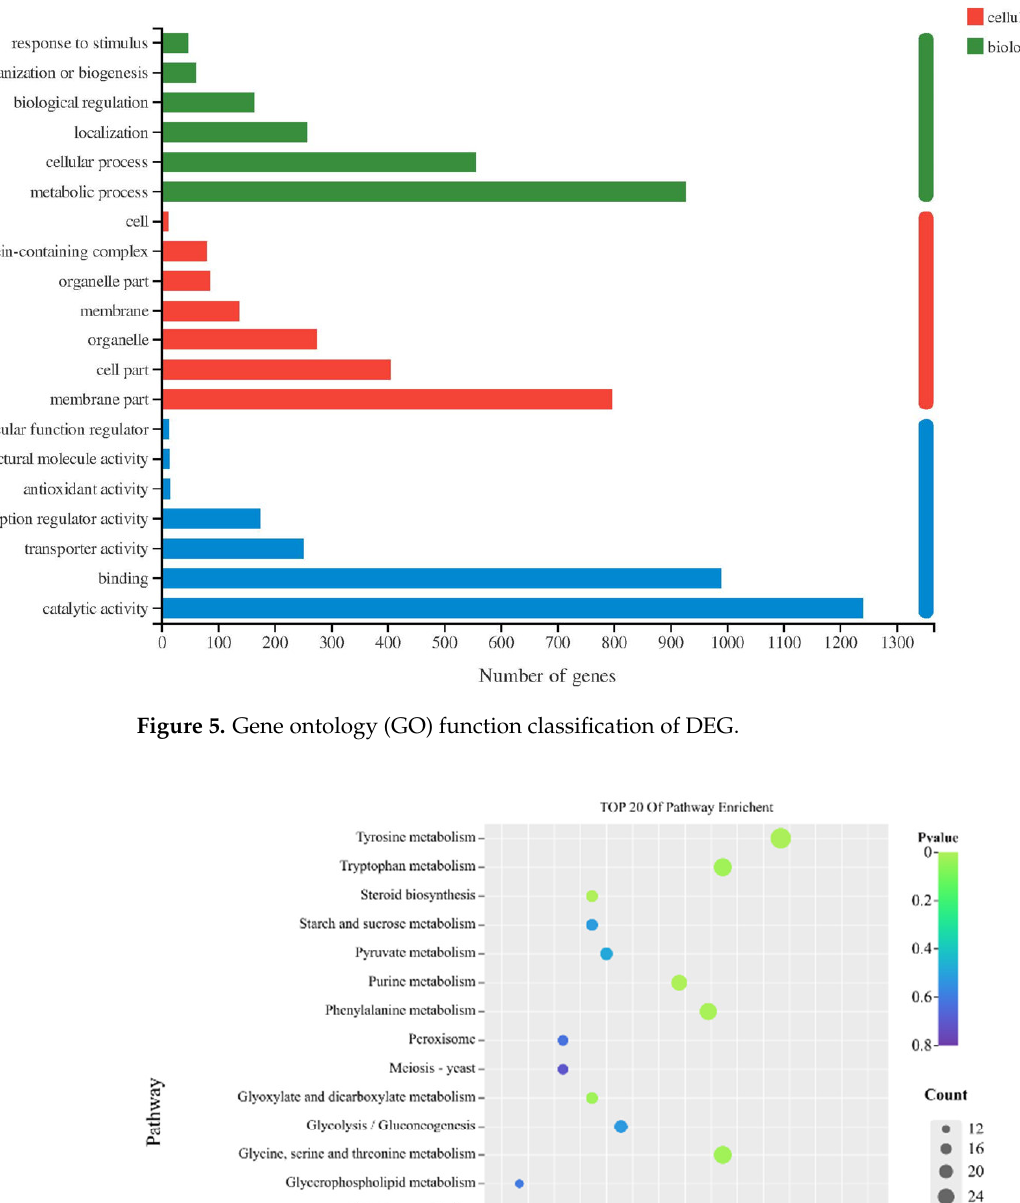
Figure 5. Gene ontology (GO) function classification of DEG.